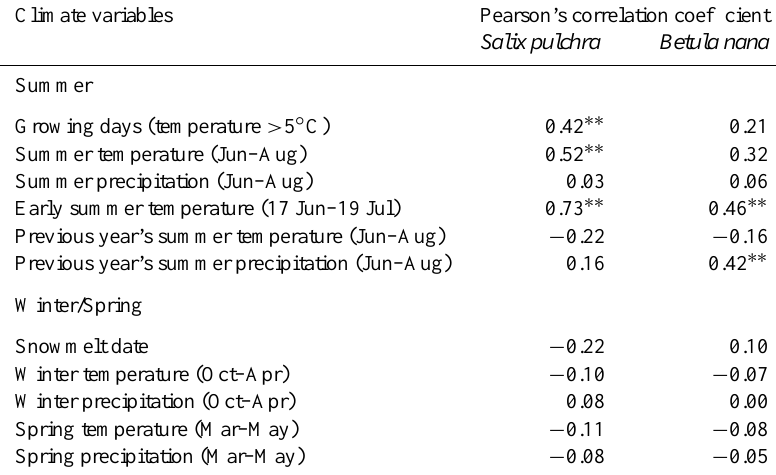
Table 2. Pearson’s correlation coefficients between shrub residual chronologies ( Salix pulchra and Betula nana ) and local climate variables temperature and precipitation (cumulative), derived from the meteorological station in Chokurdakh, for the period 1948–2006. Climate